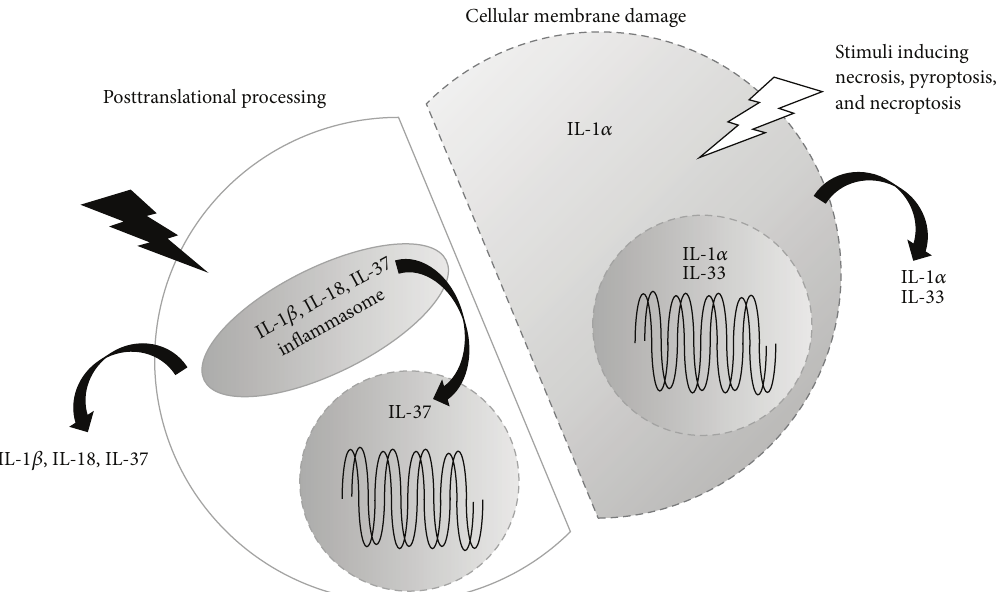
Figure 2: Modes of action of IL-1 family cytokines. All cytokines belonging to the IL-1 family, except IL-1 receptor antagonist (IL-1Ra), lack the leading peptides that are required for cell secretion. Furthermore, all full-length cytokines, except IL-1 𝛼 and IL-33, are biologically inactive unless they receive appropriate posttranslational processing. Even biologically active full-length IL-1 𝛼 and IL-33 need the appropriate cellular stimuli to be secreted from cells. IL-33 is localized in cellular nuclei, whereas IL-1 𝛼 is localized in lysosomes and perhaps in nuclei. After receiving stimuli that induce cell death via destruction of the cellular membranes (i.e., pyroptosis and necroptosis), IL-1 𝛼 and IL-33 are extracellularly liberated. In contrast, precursor- (pro-) IL-1 𝛽 , pro-IL-18, and pro-IL-37 require cleavage by caspase-1 in the inflammasome, a large multiple-protein complex (shown in Figure 3). Following appropriate stimuli, the inflammasomes are activated. Consequently, biologically active IL-1 𝛽 , IL-18, and perhaps IL-37 fragments are secreted. Bioactive IL-37 can also be translocated into nuclei. IL-36 subfamily members also require posttranslational processing for activation and excretion. However, they cannot be processed by caspase-1; their processing enzymes remain to be elucidated. pro: